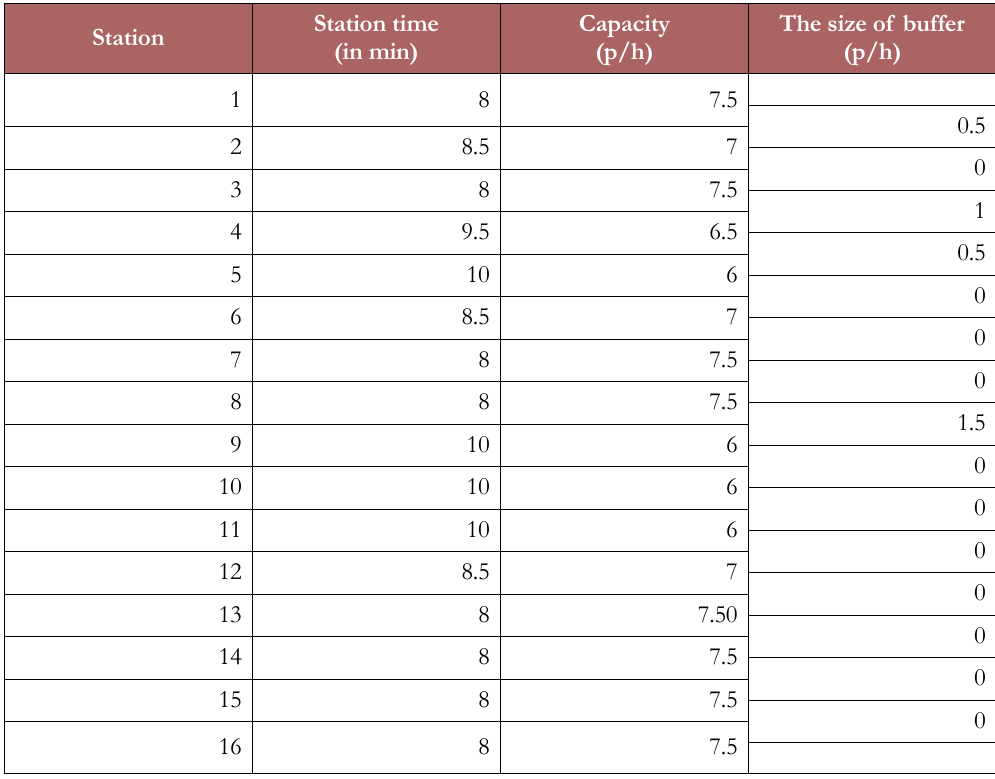
Table 4. Sizing of buffer